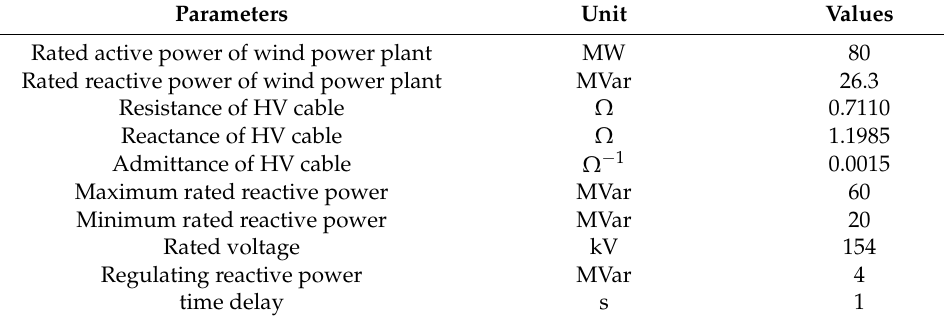
Table 1. Parameters of test VSR